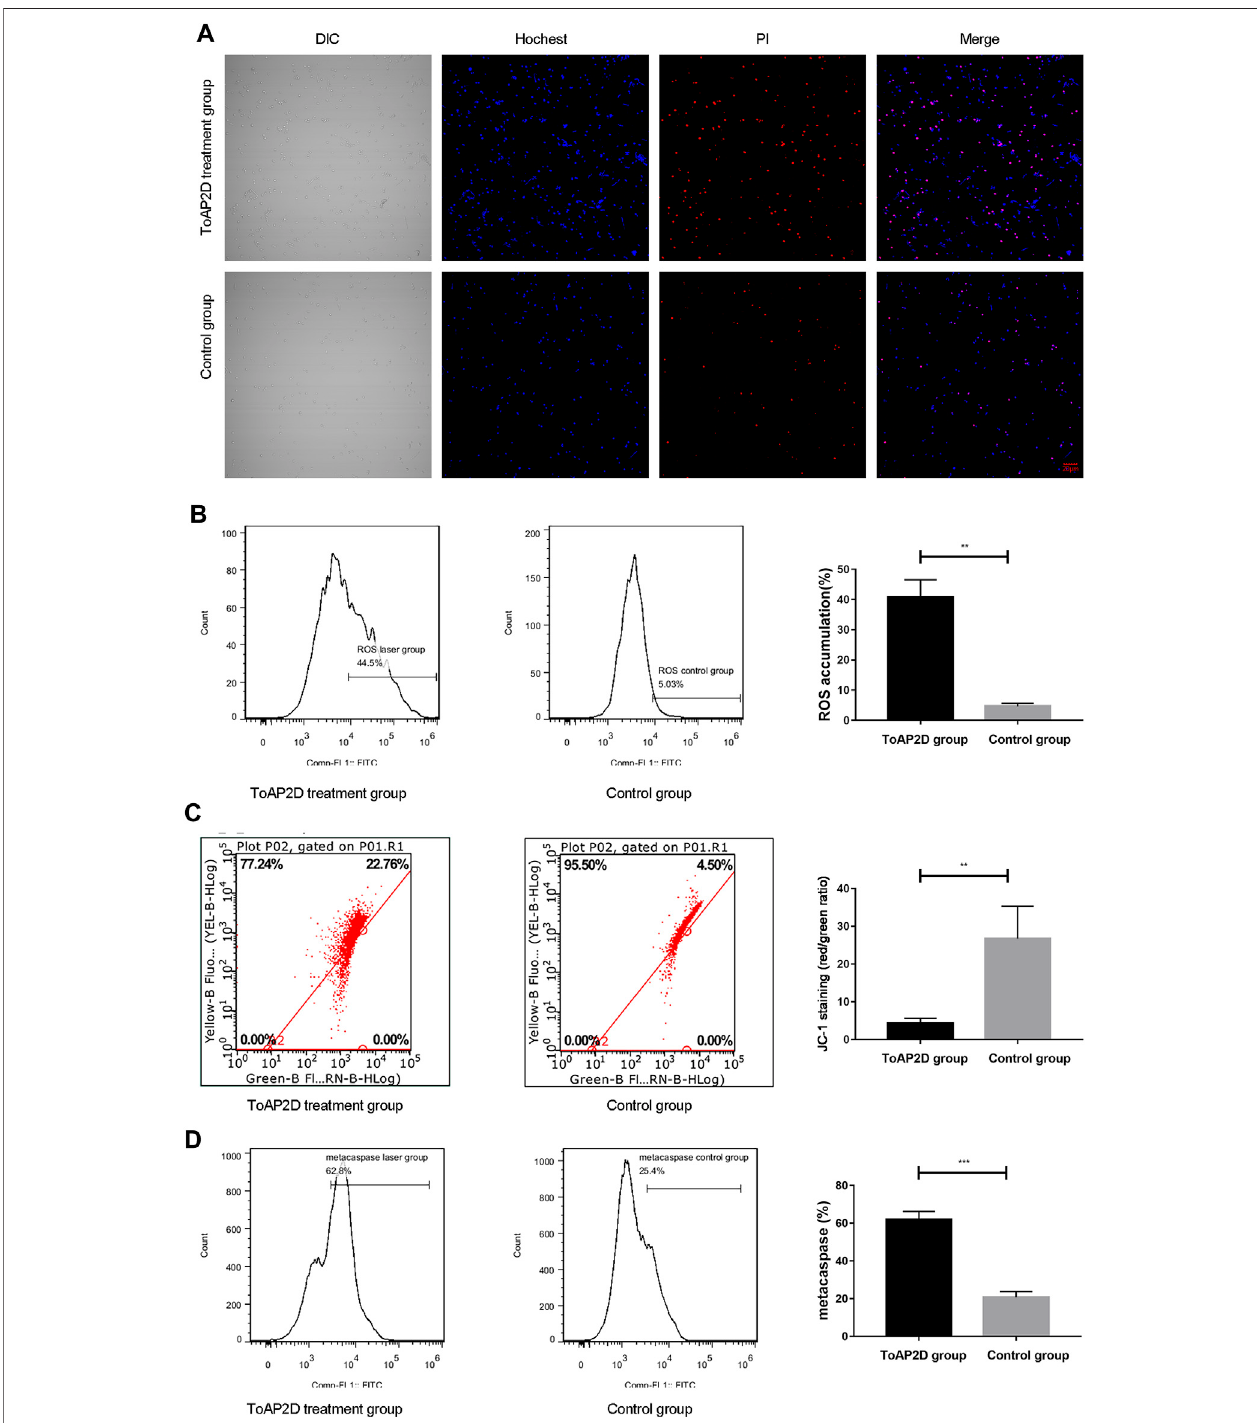
FIGURE 4 | Effect of ToAP2D treatment on apoptosis of S. globosa . (A) Laser scanning confocal microscope was used to observe the apoptosis and necrosis effect of ToAP2D treatment. The scale bar (cid:2) 20 μ m. (B) Flow cytometry was used to detect the ROS accumulation. (C) Flow cytometry was used to detect the mitochondrial membrane potential. (D) Flow cytometry was used to detect the metacaspase activation. * p < 0.05, ** p < 0.01, and *** p < 0.001 indicate statistical signi fi cance.